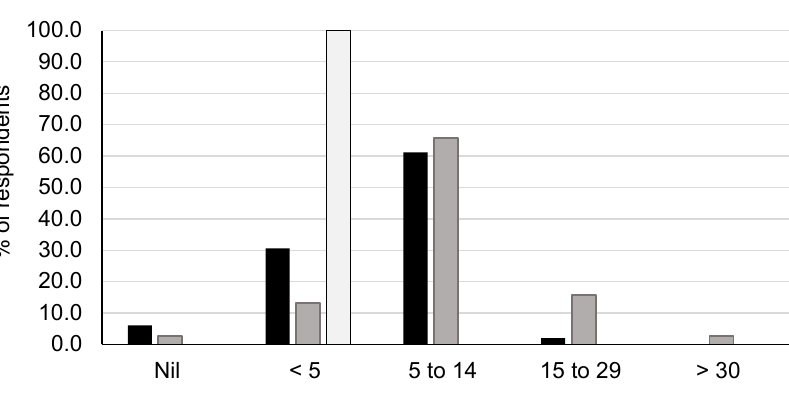
Figure 1. Average number of hours on spent unpaid domestic work for household in a typical week during the COVID-19 pandemic lockdown